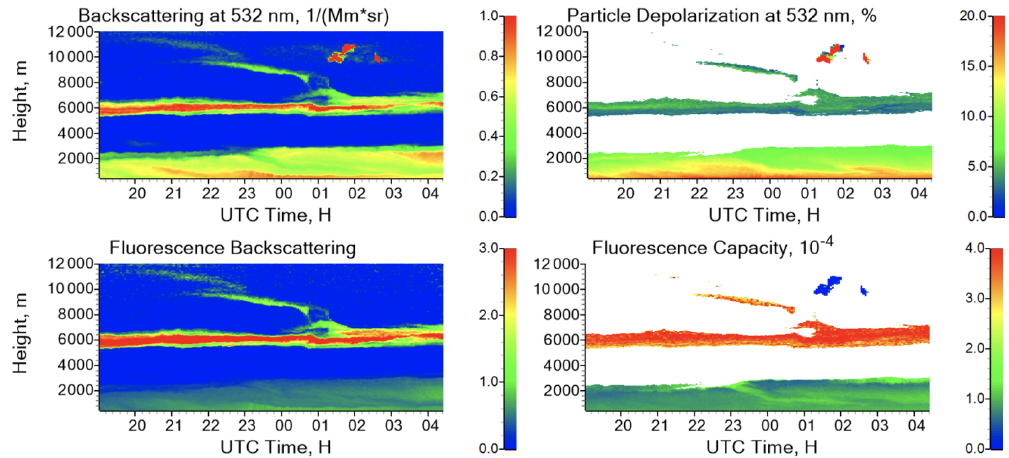
Figure 8. Spatiotemporal distributions of the backscattering coefficient β 532 , the fluorescence backscattering coefficient β F (in 10 − 4 Mm − 1 sr − 1 ), the particle depolarization ratio δ 532 , and the fluorescence capacity G F on the night of 14–15 September 2020. The values of δ 532 and G F are shown for β 532 > 0.2Mm − 1 sr − 1 .